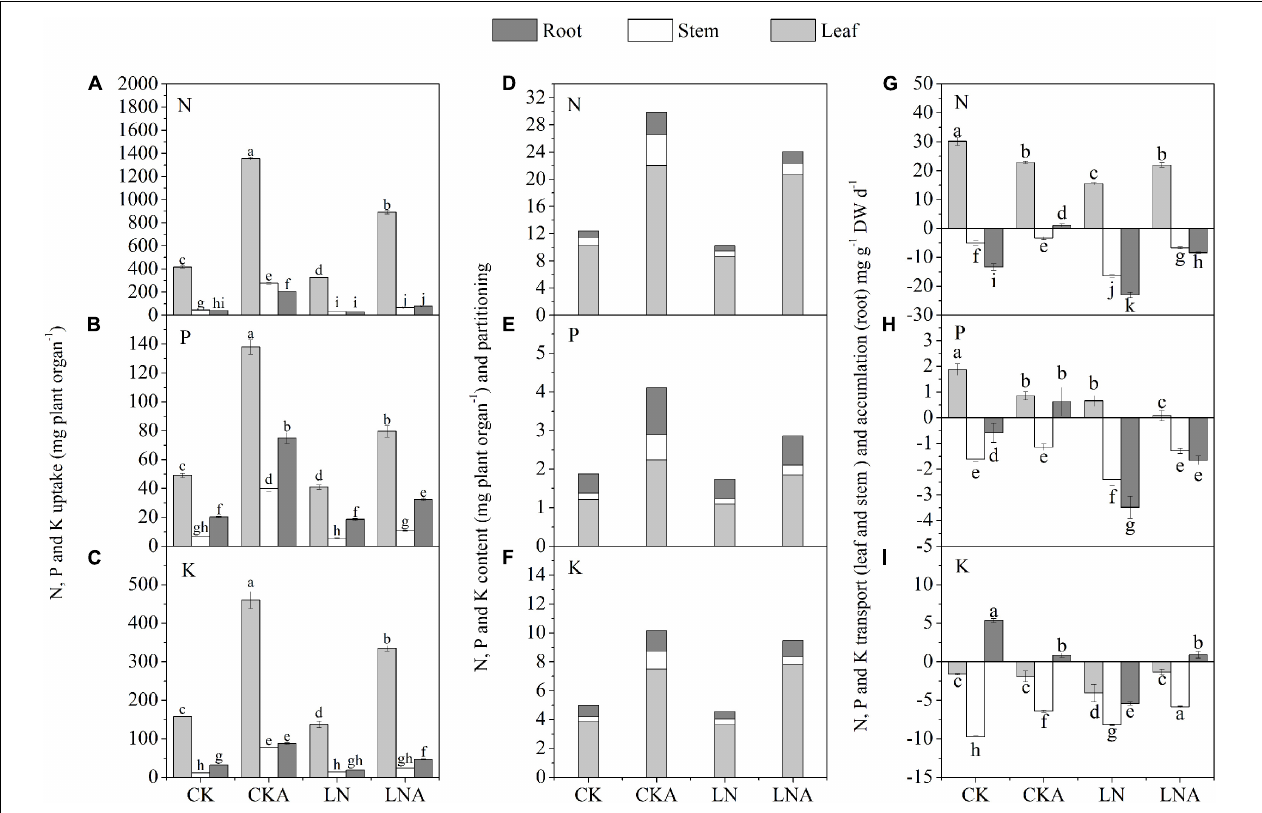
FIGURE 3 | Effects of arginine on N, P, and K in M. hupehensis under low N. The uptake of total N (A) , K (B) , and P (C) in the leaves, stems, and roots. The accumulation and partitioning of N (D) , P (E) , and K (F) and transport of N (G) , P (H) , and K (I) in the leaves, stems, and roots. Values are means of three replicates ± SD. Values not represented by the same letter are significantly different according to Tukey’s multiple-range test ( P < 0.05).